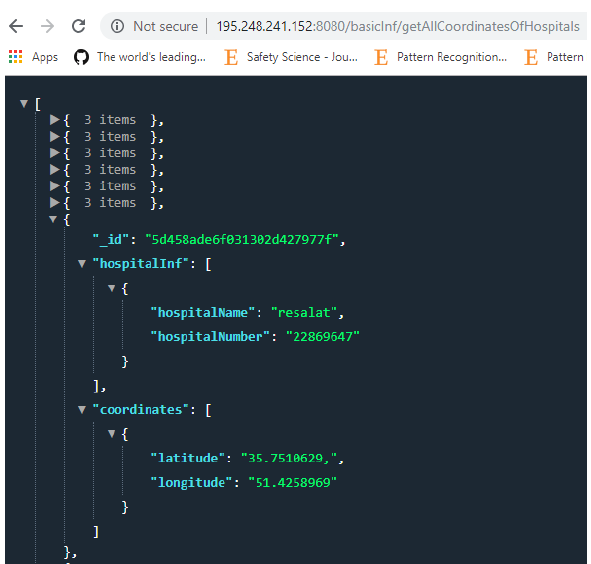
Figure 6: The result of web service 3: Get all coordinates of hospitals (JSON parse).